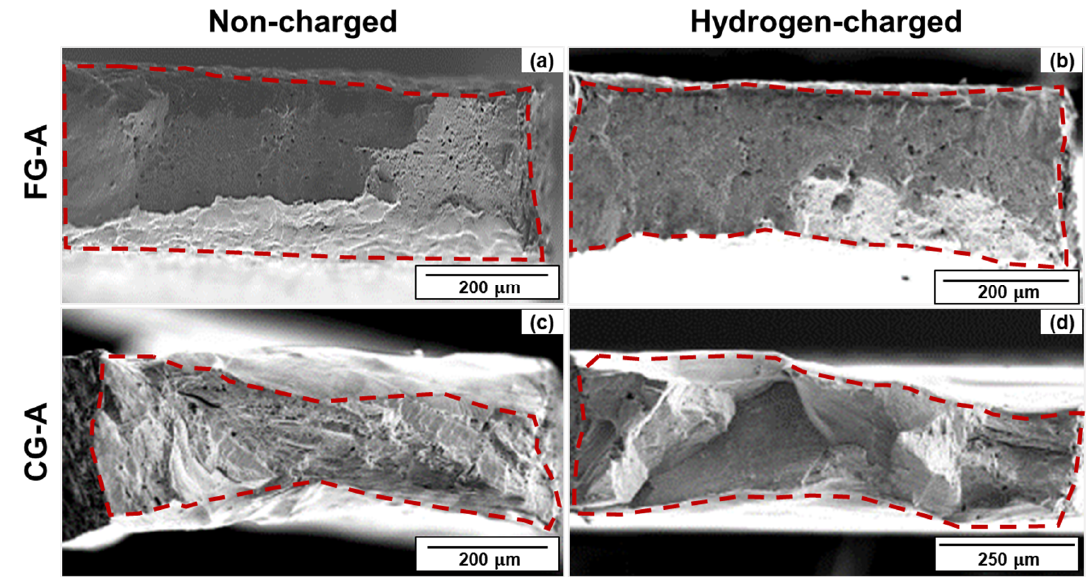
Figure 5. Fractographs of ( a , b ) FG-A and ( c , d ) CG-A specimens; in ( a , c ) non-charged and ( b , d ) hy- drogen-charged conditions. The red dotted line in each image indicates boundary of fracture surface.